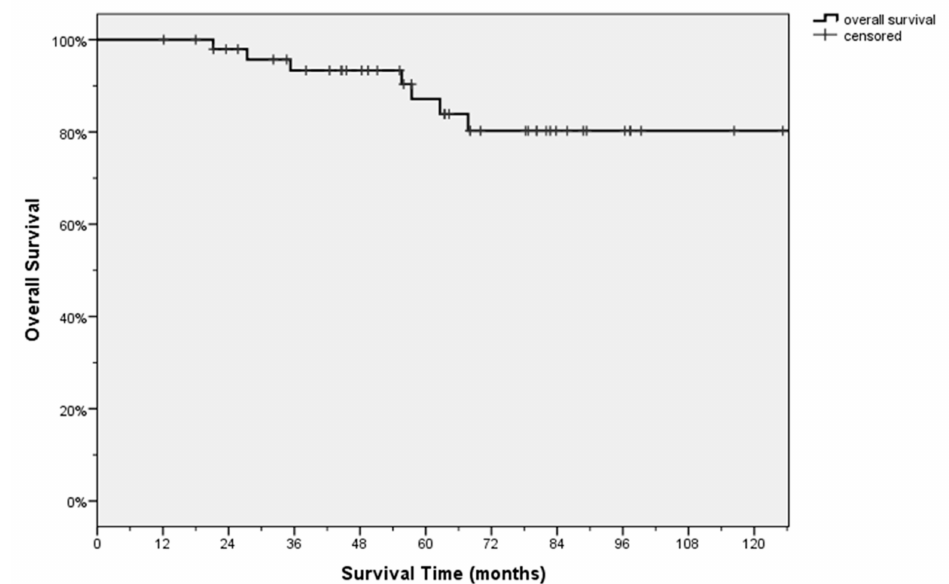
Figure 2. Kaplan-Mayer-Analysis of Overall Survival (OS) of the 50 patients enrolled in the study.